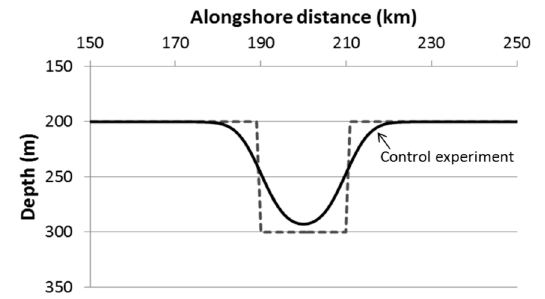
Figure 3. Variations of canyon shapes discussed in this paper. Shown are bathymetric transects along the shelf break at y = 60 km. The solid line represents the configuration of the control experiment. The dashed line denotes a box-type canyon considered in sensitivity studies.